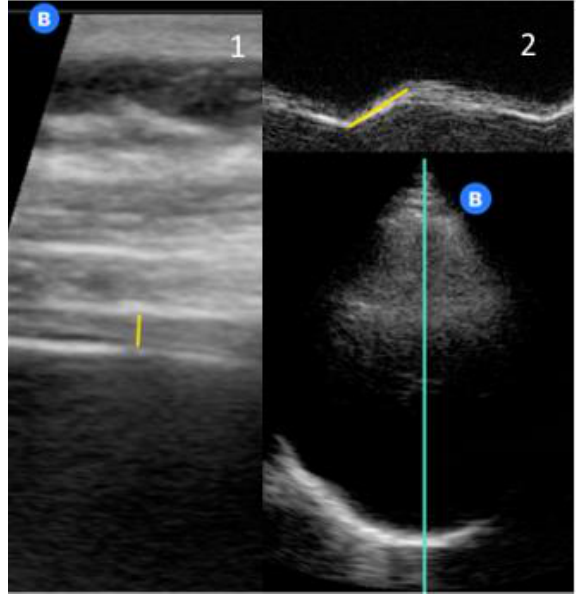
Figure 1. Example of DUS measurements: Panel 1 shows diaphragmatic thickness at end-expiration; Panel 2 shows diaphragmatic motion (the white B in the blue dot is the probe marker).